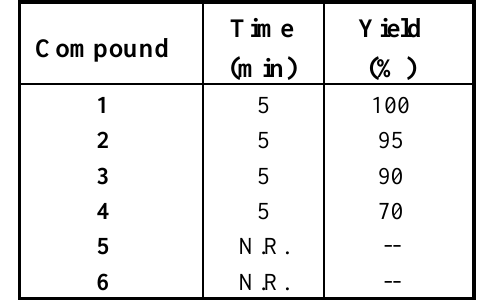
Table 2. Solid phase oxidation of benzoins on alumina under microwave irradiation.